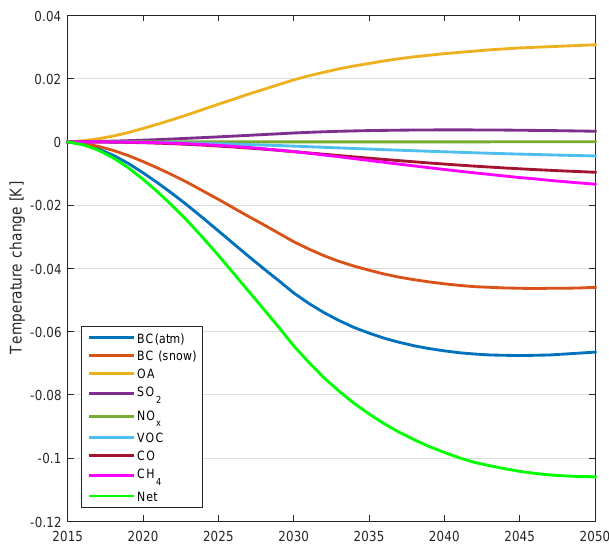
Figure 22. Total Arctic surface temperature change (K) by global mitigation of residential burning (heating and cooking) in the ECLIPSE emission scenario (MIT–CLE), as obtained with the ARTP